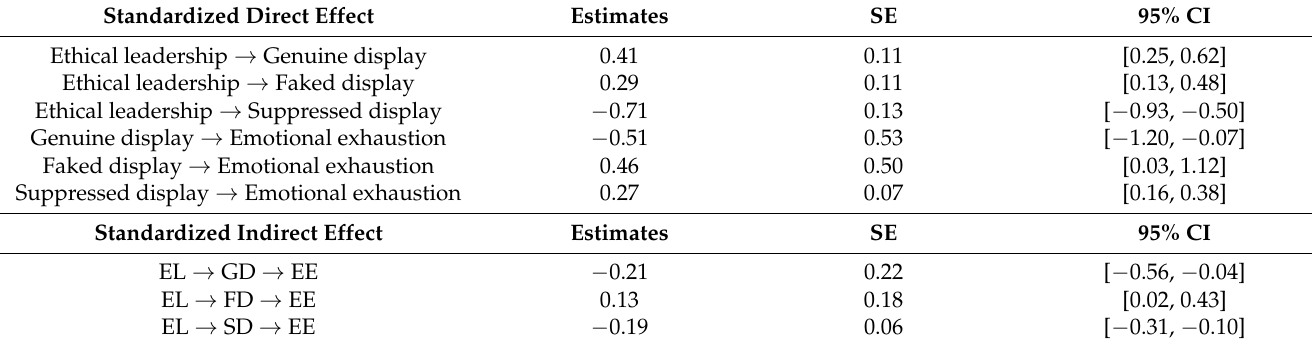
Table 3. Summary of standardized direct and indirect